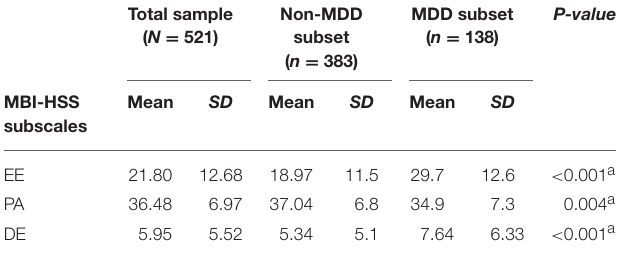
TABLE 2 | Severity of burnout according to the MBI-HSS, total sample, MDD and non-MDD